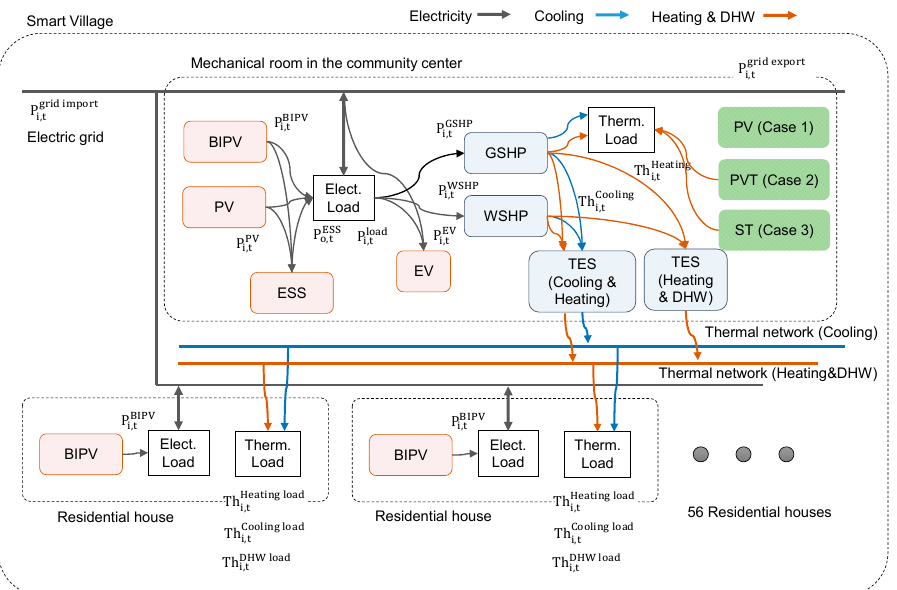
Figure 1. Schematic of a hybrid energy system for an energy-sharing community in a smart village.